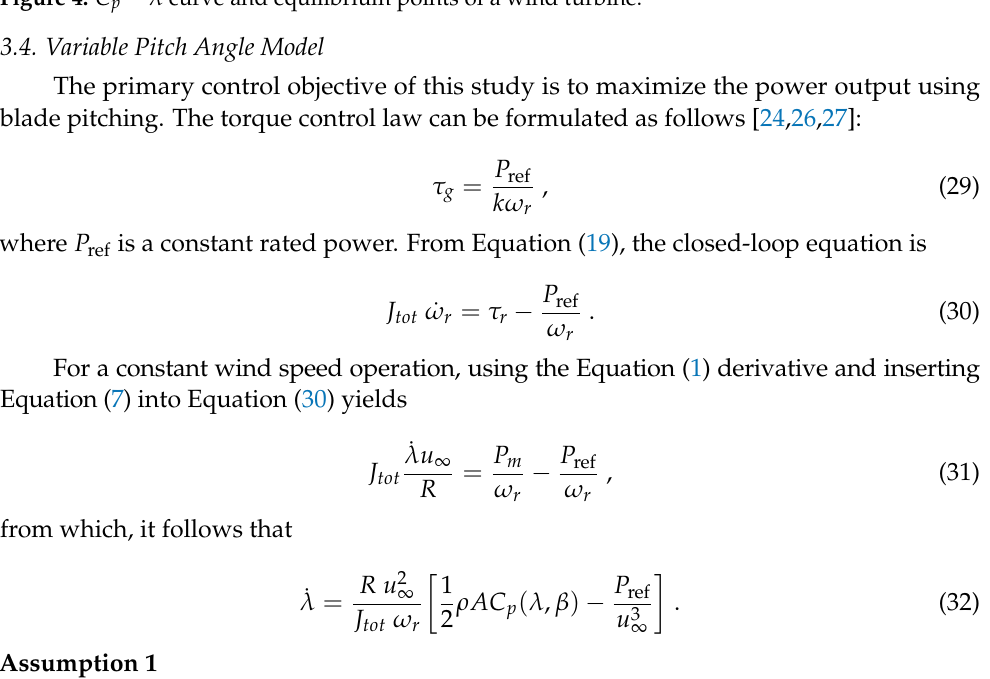
Figure 4. C p − λ curve and equilibrium points of a wind